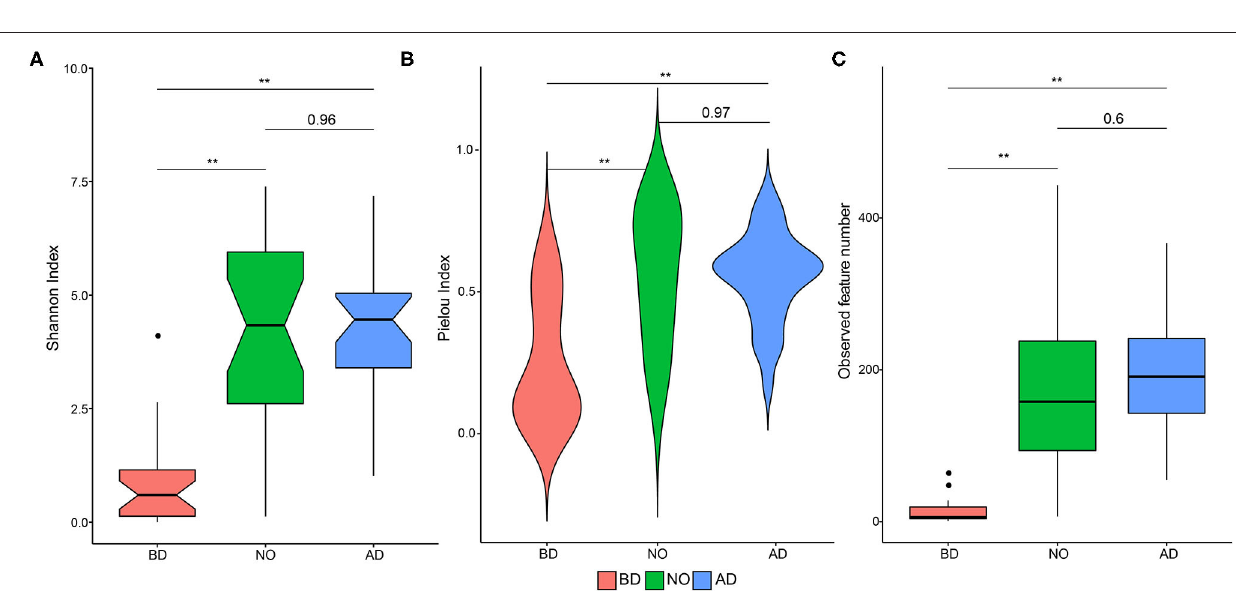
high-variable regions. A total of 3,788,402 reads were